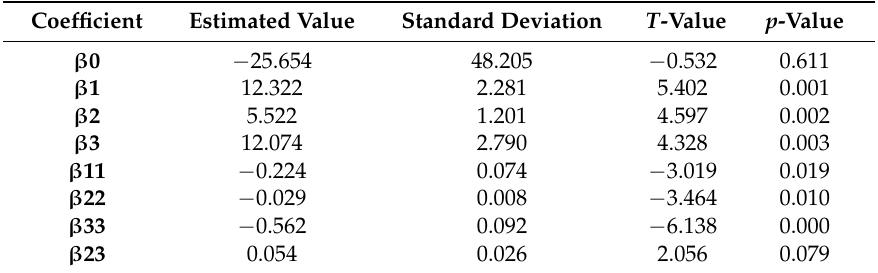
Table 6. Statistical parameters for the model coefficients based on the Box-Behnken design. Coefficient